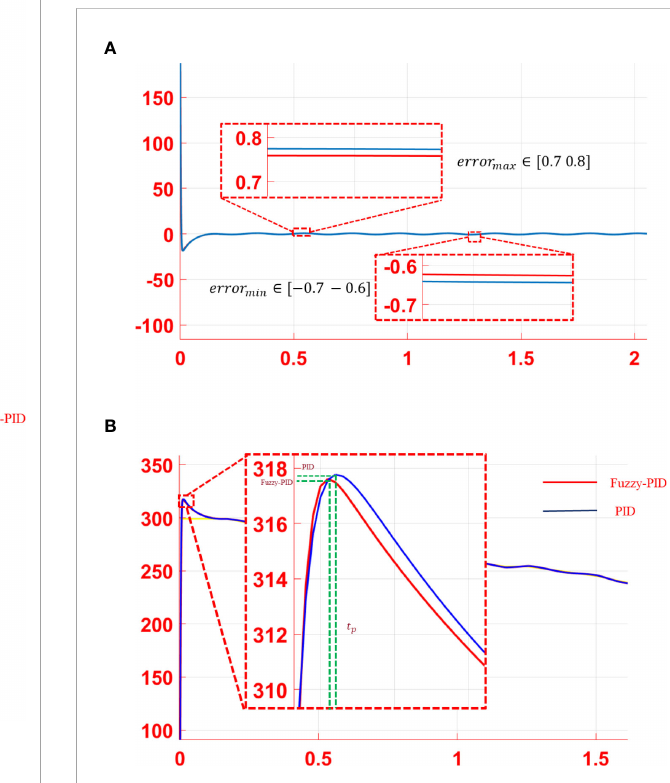
FIGURE 5 Analysis of the simulation results: (A) error curve and (B) performance analysis of tracking